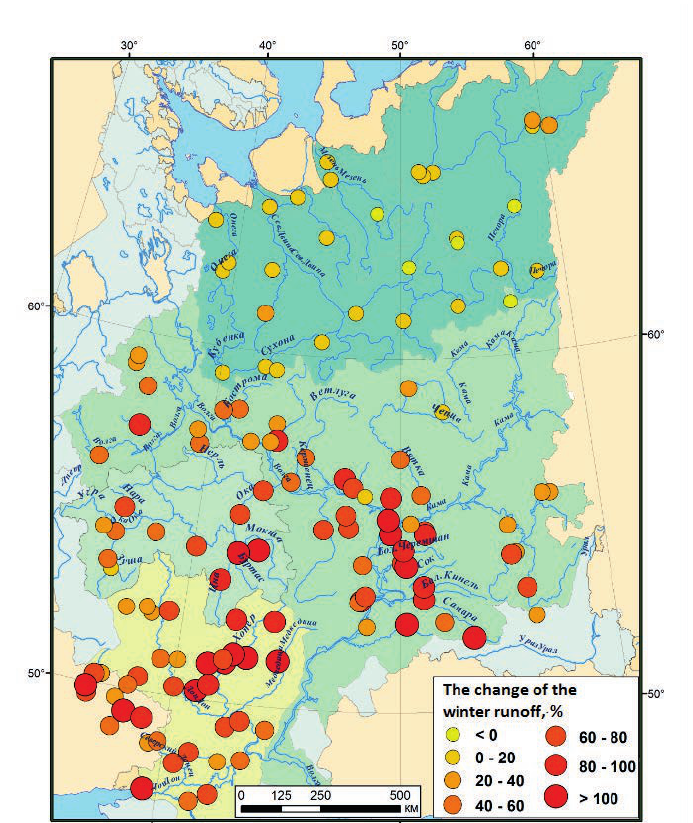
Fig. 4 Changes in the winter low-water flow in the rivers of Don and Volga basins and rivers in the northern European Russia for the period from 1975 to 2010 relative to the period from 1945 to 1974, in percent.